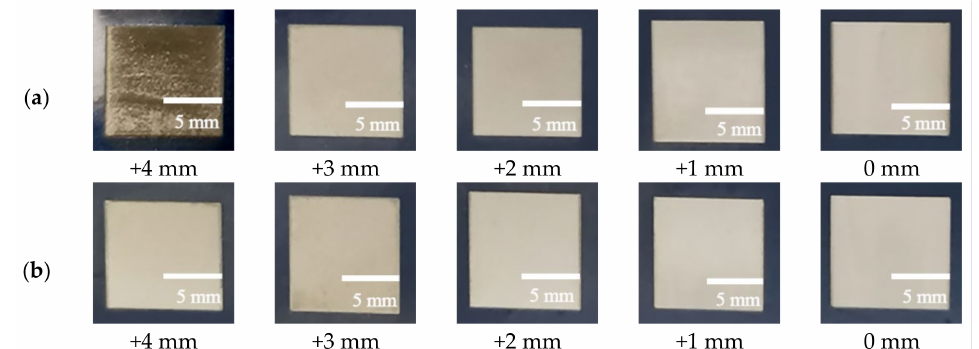
Figure 8. Photos of the samples laser scanned 3 times when defocus distances were 0–+4 mm: ( a ) in ambient air, ( b ) in inert gas (Ar).